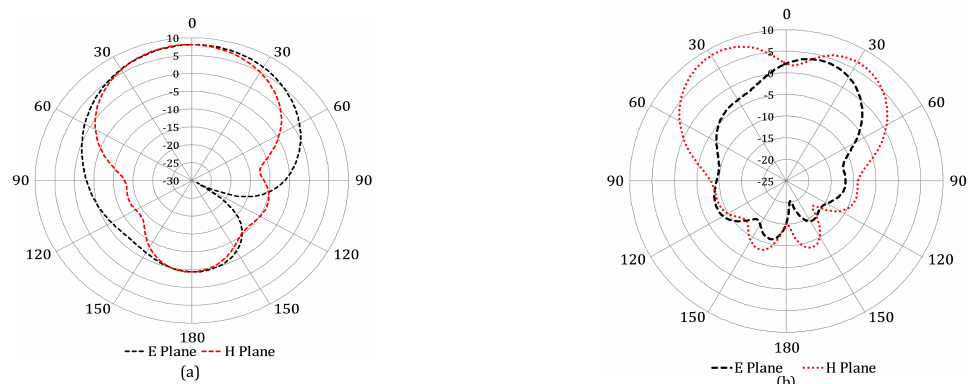
Figure 12. Gain patterns of conventional dual band antenna at ( a ) 2.5 GHz and ( b ) 5.2 GHz. The distribution of surface currents in the conventional wearable antenna at 2.5 and 5.2 GHz is shown in Figure 13, which clearly shows the resonant lengths.